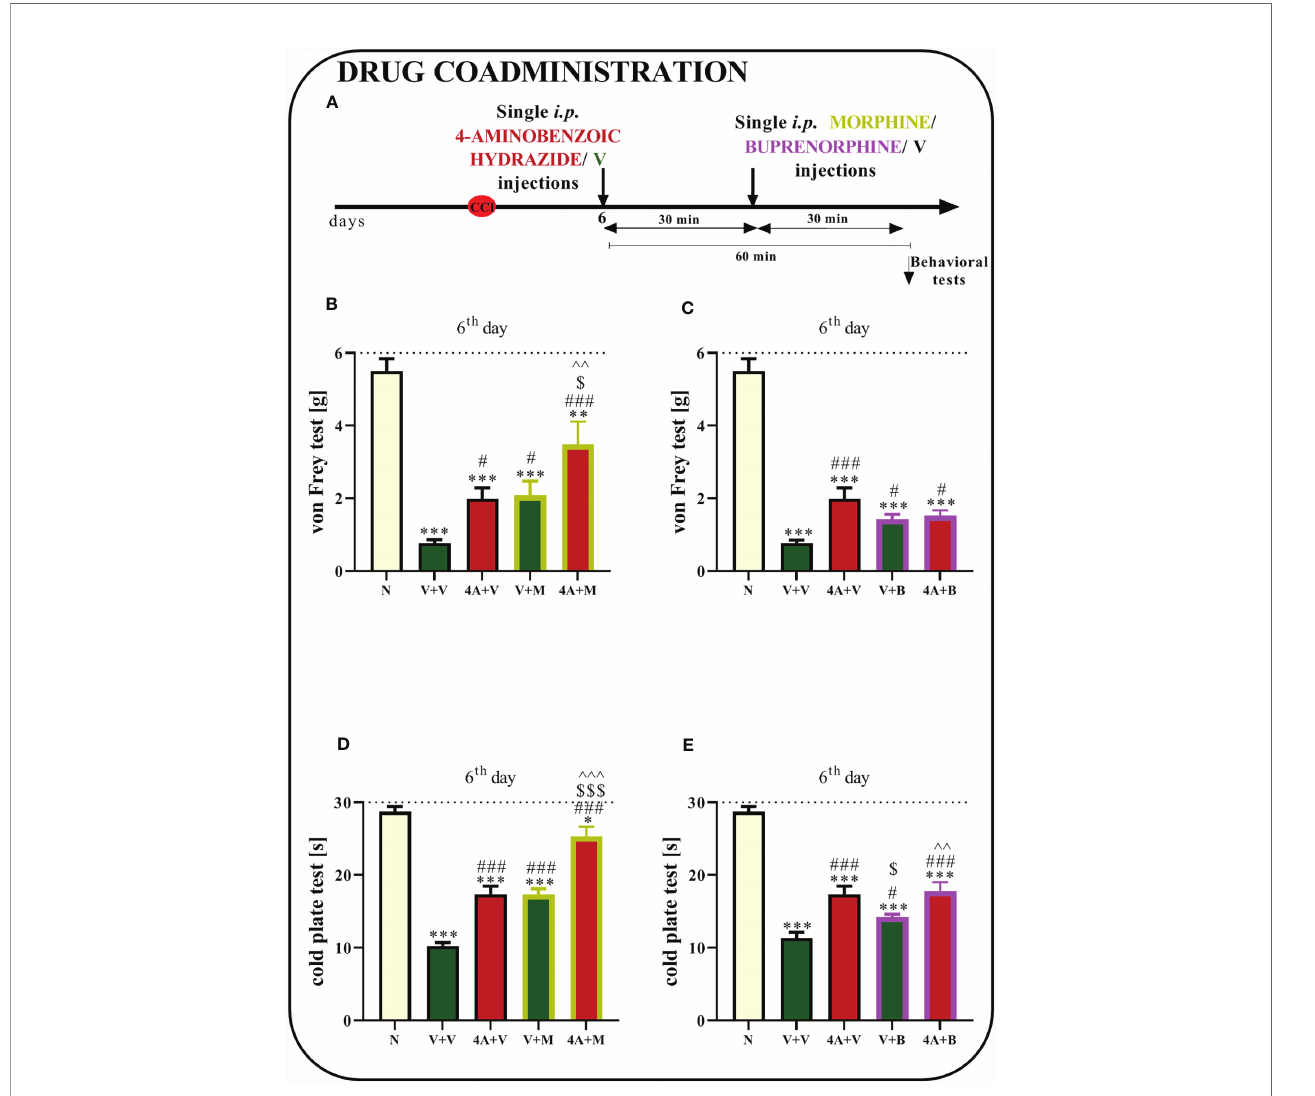
FIGURE 10 | Effect of a single administration of 4-aminobenzoic hydrazide [4A; 60 mg/kg; i.p. (A) ] on pain-related behaviors in mice [von Frey test - (B, C) and cold plate test - (D, E) ] and the analgesic effects of morphine (M) [5 mg/kg, i.p .; (B, D) ]. and buprenorphine (B) [5 mg/kg, i.p.; (C, E) ] 1 h after vehicle or 4A injections (30 min after opioids injections) on the 6 th day post- chronic constriction injury of the sciatic nerve (CCI). The data are presented as the means ± SEM of 7 – 8 mice per group. The horizontal dotted line shows the cutoff value. Intergroup differences were analyzed using ANOVA with Bonferroni ’ s post hoc test for multiple comparisons. *P < 0.05, **P < 0.01, and ***P < 0.001 indicate a signi fi cant difference compared with the control group (naive, N mice); # P < 0.05 and ### P < 0.001 indicate a signi fi cant difference compared with the Vehicle (V)-treated group; $ P < 0.05 and $$$ P < 0.001 indicate a signi fi cant difference compared with the 4A+V-treated group; ^^P < 0.01 ^^^P < 0.001 indicate a signi fi cant difference between the V+M- and 4A+M-treated mice and between the V+B- and 4A+B-treated